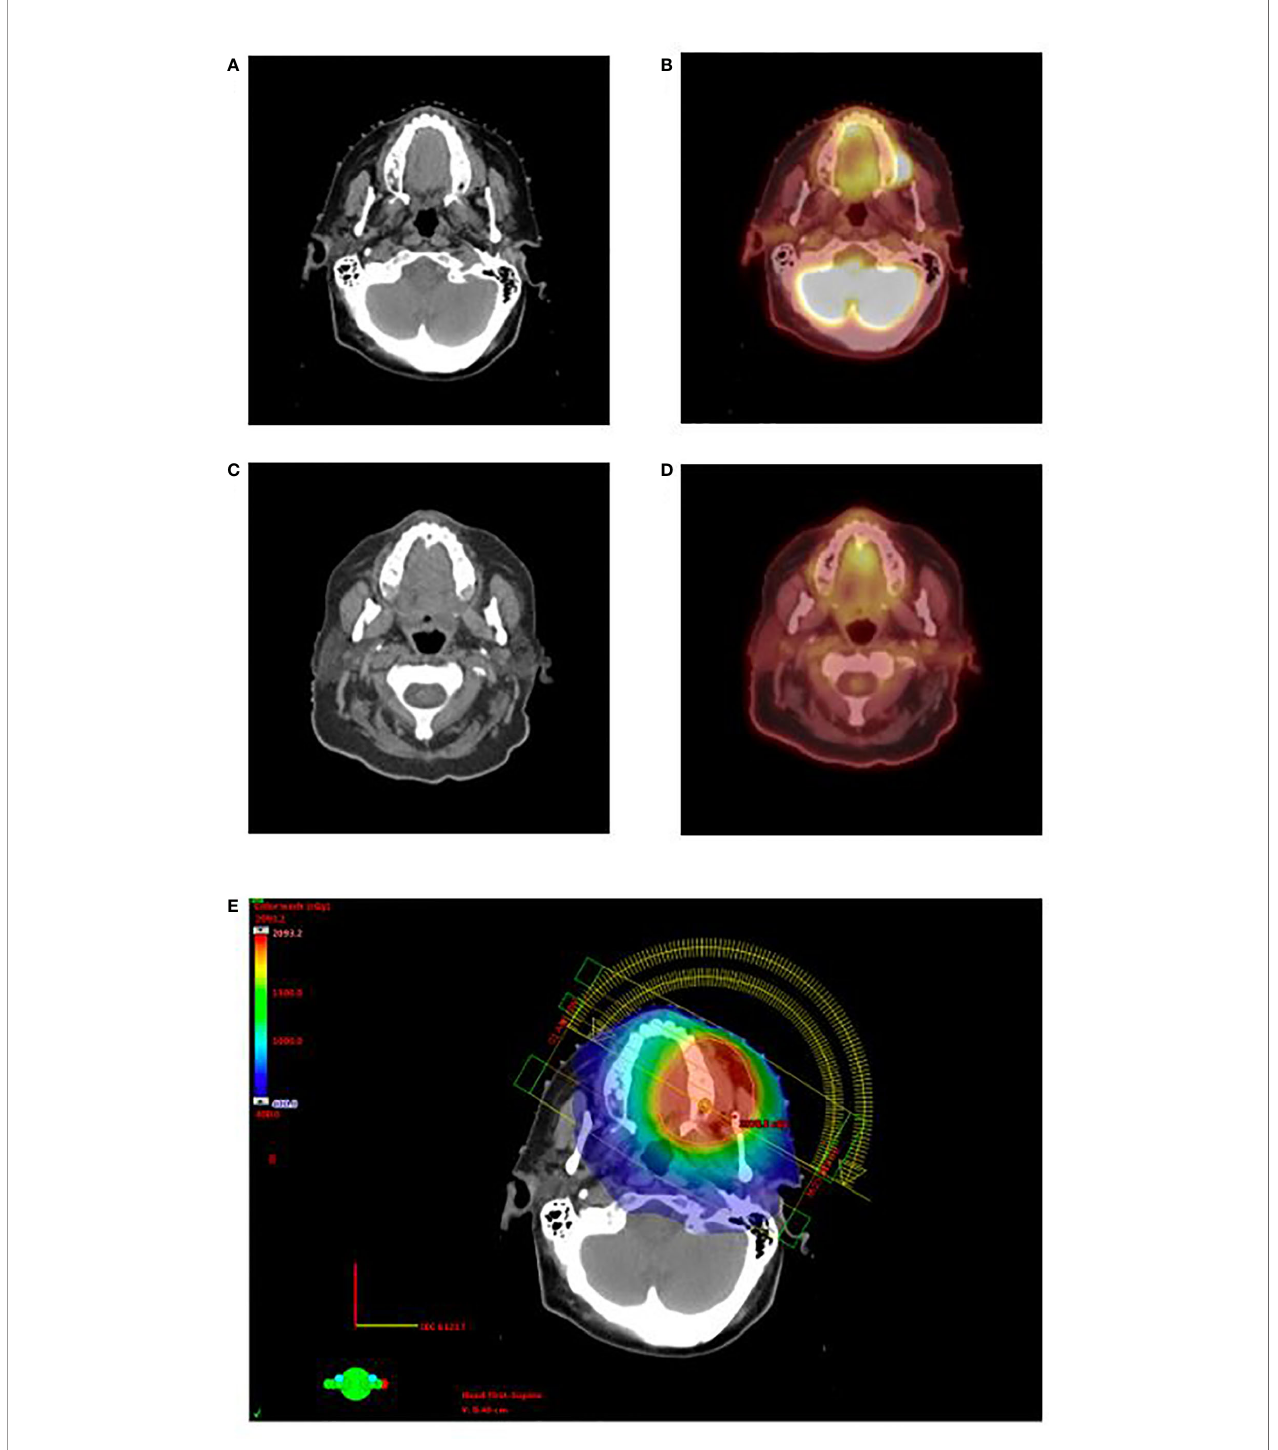
FIGURE 1 | Clinical appearance of gingival MS in the left superior alveolar ridge for patient 1 on pretreatment CT (A) and PET/CT (B) . The patient demonstrated complete response on CT (C) and PET/CT (D) 3 months after the completion of RT. Rapid arc IMRT treatment plan is shown in (E) . CT, computed tomography; PET/CT, positron emission tomography/computed tomography; RT, radiotherapy; IMRT, Intensity modulated radiation